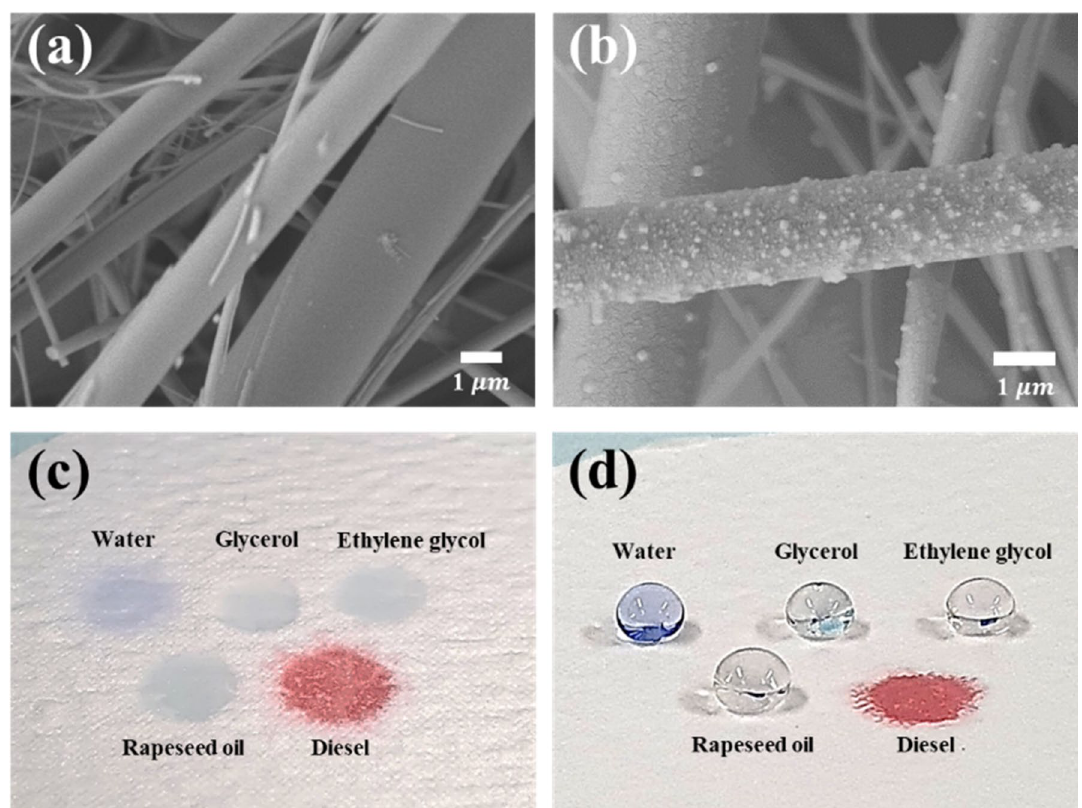
Figure 1. SEM images of ( a ) pristine GMF membrane and ( b ) modified GMF membrane. Optical images of liquid droplets with different surface tensions on ( c ) pristine GMF membrane and ( d ) modified GMF